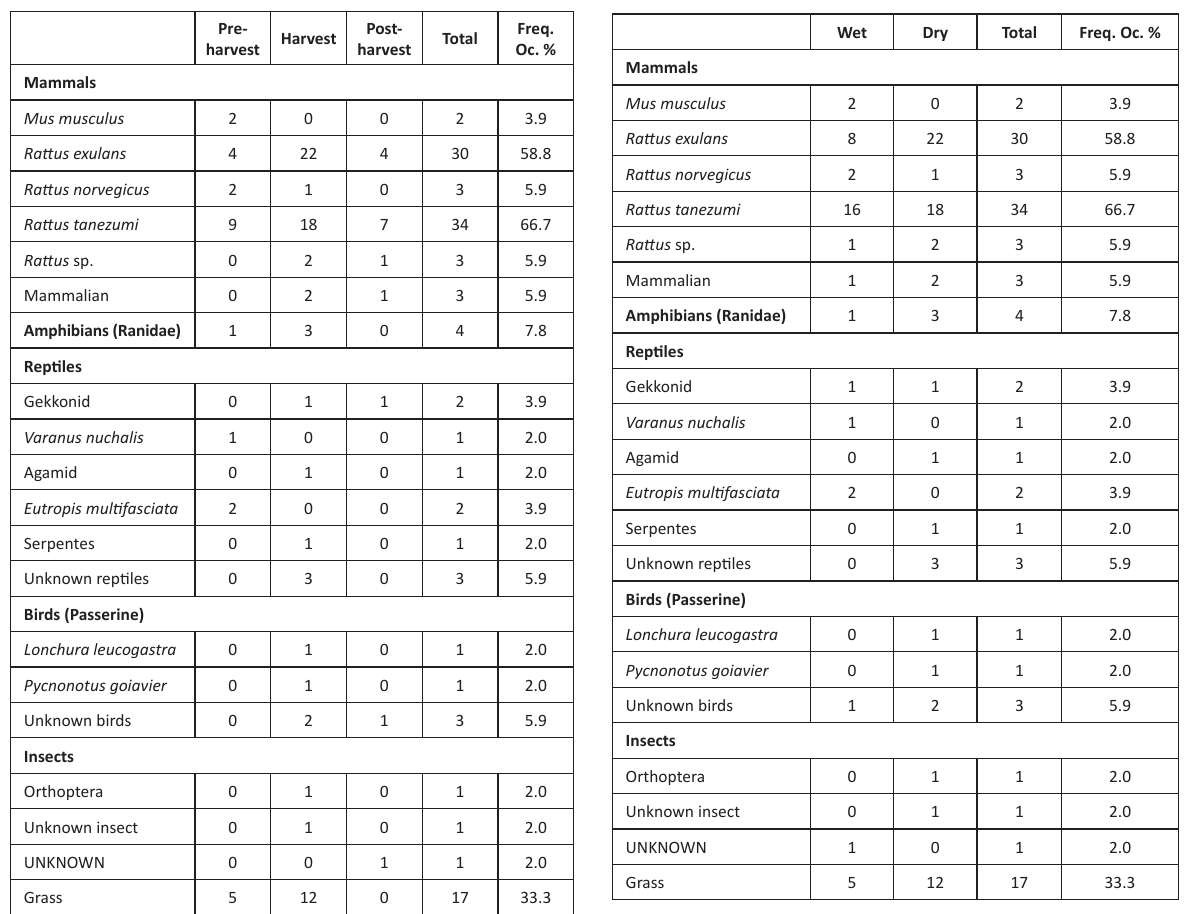
Table 4. Taxonomic composition of prey according to sugarcane harvest cycle (n=51).